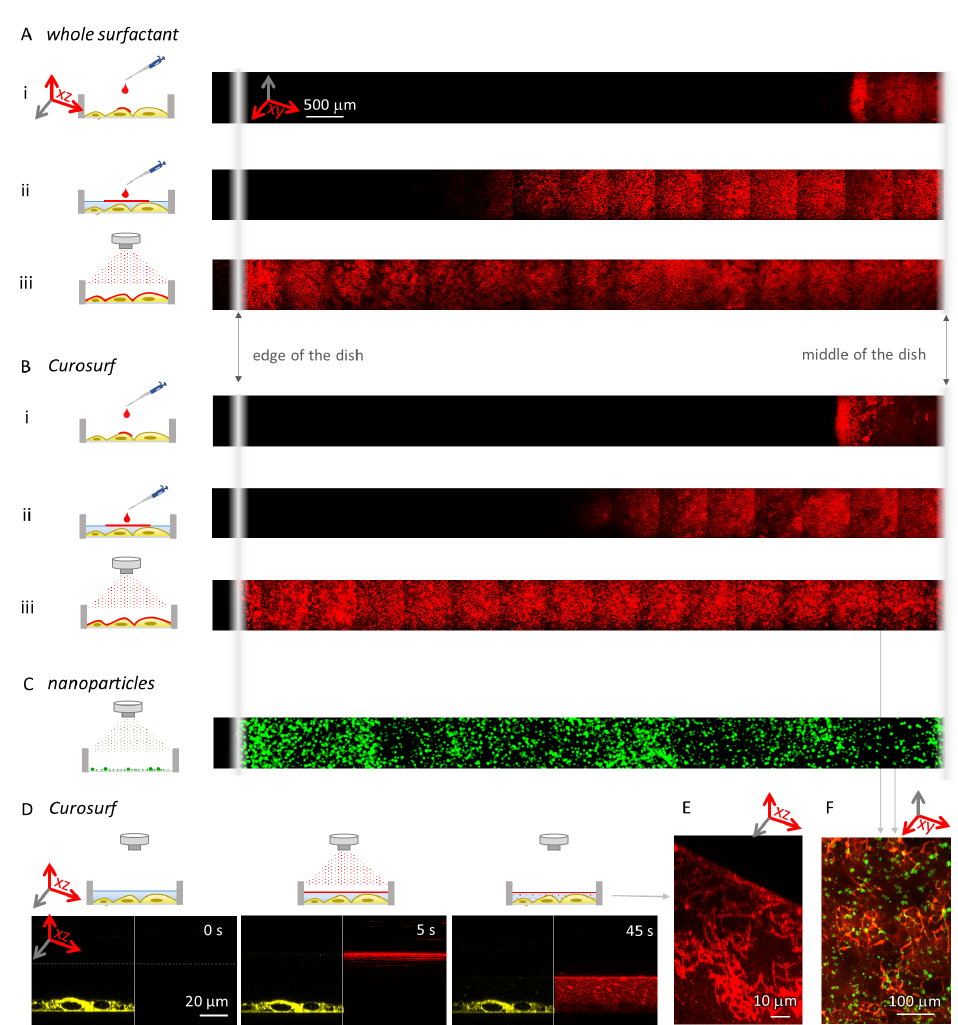
Figure 3. The deposition of nebulized and pipetted surfactant. A total of 10 monolayers of fluores- cently labelled ( A ) whole surfactant and ( B ) Curosurf were administered onto cells using different methods. As shown in the top-view panoramas, in both cases ( i ) surfactant, pipetted onto cells with removed medium (simulating ALI conditions), spreads only over a fraction of the sample, ( ii ) surfactant pipetted onto cells slightly covered with cell medium spreads further, but still does not cover the entire sample, and ( iii ) nebulized surfactant evenly covers the entire sample (fluorescence intensities are reported in Figure S3). Note that the intensities are not comparable between measure- ments, and the dark vertical lines are the consequence of uneven illumination. ( C ) Nebulization of fluorescently labelled TiO 2 nanotubes (green) evenly deposits the material over the sample—shown here in a top-view panorama for nebulization directly onto a glass surface. Note that, due to the low signal, the image was filtered using a Gauss filter, and the intensity was scaled from 0 to 3 counts. ( D ) A time series of nebulization of 10 monolayers of Curosurf (red, fluorescently labelled with STAR RED-DPPE) onto lung alveolar cells (green, labelled with CellMask Orange), (see Figure S2 for com- plete time series). ( E ) A side-view of the surfactant structure just below the surface after nebulizing 100 monolayers of surfactant (red) onto submerged cells. The surface of the medium is tilted due to capillary effects near the edge of the dish. ( F ) A fluorescence top-view micrograph of 10 monolayers of nebulized surfactant (red) and subsequently nebulized 1:1 surface dose of nanomaterial (green) onto lung alveolar